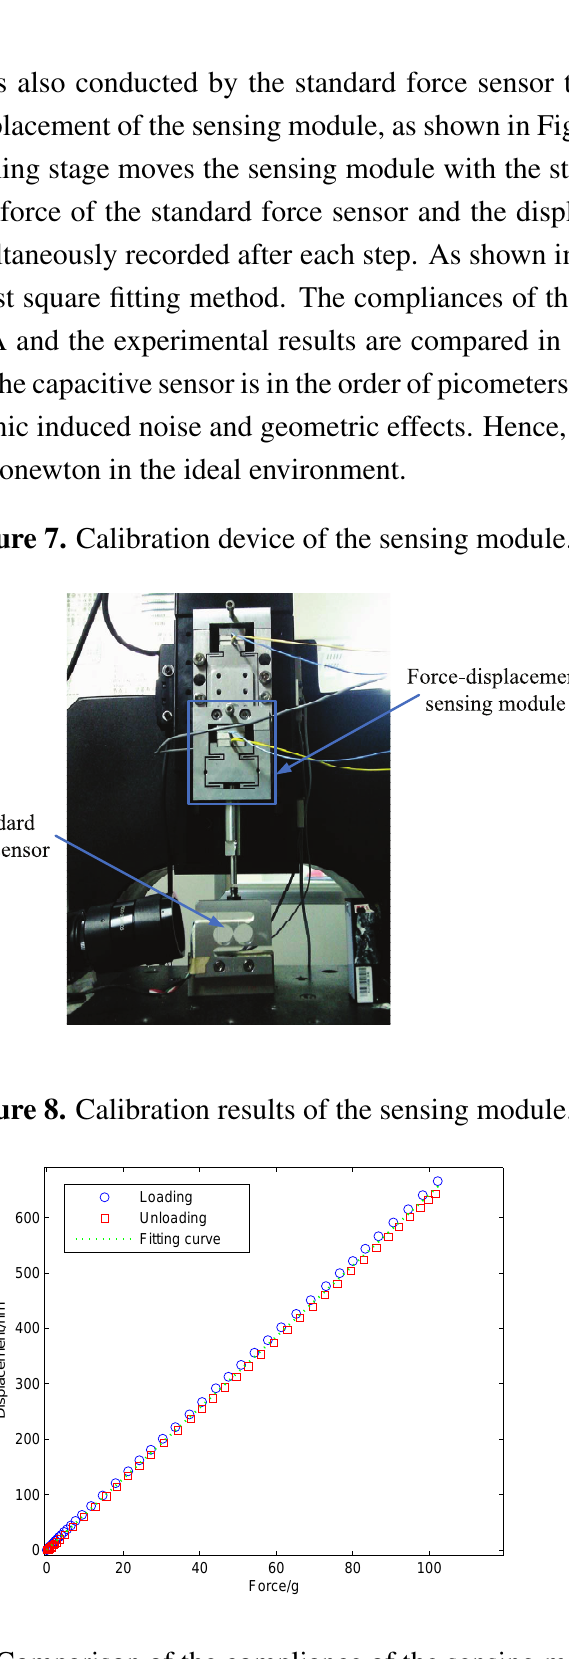
Table 1. Comparison of the compliance of the sensing